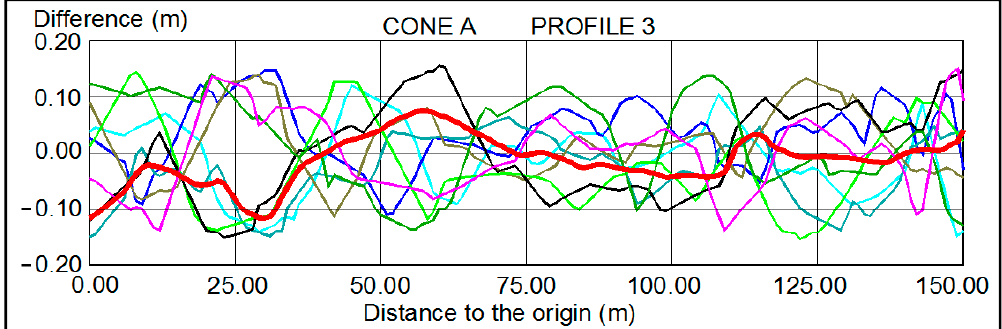
Figure 9. Predictive representation (in red) of profile 3 of Cone A. The rest of the curves belong to the space of Hilbert L 2 . [ 0,1 ]